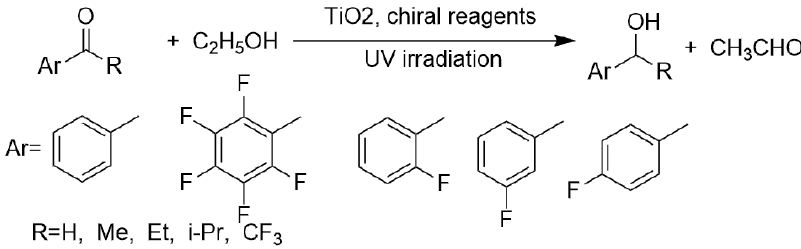
Molecules 2019 , 24 , x FOR PEER REVIEW 8 of 21 3. Transfer Hydrogenation of C=O and C=N Bonds Transfer hydrogenations of C=O bonds are extremely important since a variety of pharmaceuticals, agrochemicals and natural products are required to possess the bioactive asymmetric C-OH center, which can be conveniently prepared from the enantioselective reduction of the corresponding carbonyl compounds. Compared with transfer hydrogenations of C=C and C  C bonds, TiO 2 photocatalyzed transfer hydrogenations of C=O bonds have garnered more successes. The reason lies in that the hydrophilic TiO 2 surface could effectively adsorb polar organic compounds by hydrogen bonds and coordination interaction of C=O lone-pair electrons with Ti 3d empty orbitals. In this way, polar C=O bonds could be facilely converted to C-OH bonds by interfacial electron/proton transfer, hydride transfer or hydrogen atom transfer delivered by HDC such as methanol, ethanol, i-propanol or triethylamine on TiO 2 nanoparticle surface. Kohtani’s group has conducted a series of excellent work on TiO 2 photocatalytic transfer hydrogenations of aryl carbonyl compounds using alcohols as hydrogen donors [55,85 – 90]. In their most recent work, even moderate enantioselectivity for aryl keton es’ conversion to chiral secondary aryl alcohols was realized (as shown in Scheme 8) [56]. Although previous work of Kö nig’s group had proved that the combination of TiO 2 photocatalysis and imine organocatalysis could facilitate the